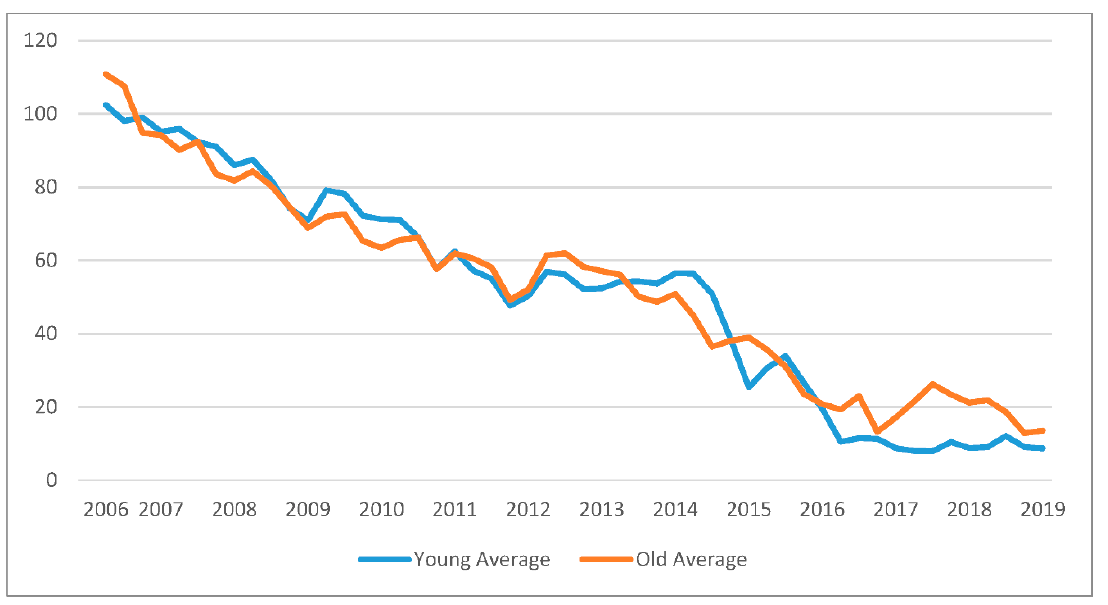
Figure A4. Total landfill waste (kg) per person by average age in the youngest and oldest local authorities in Wales – quarterly. Source: WasteDataFlow.